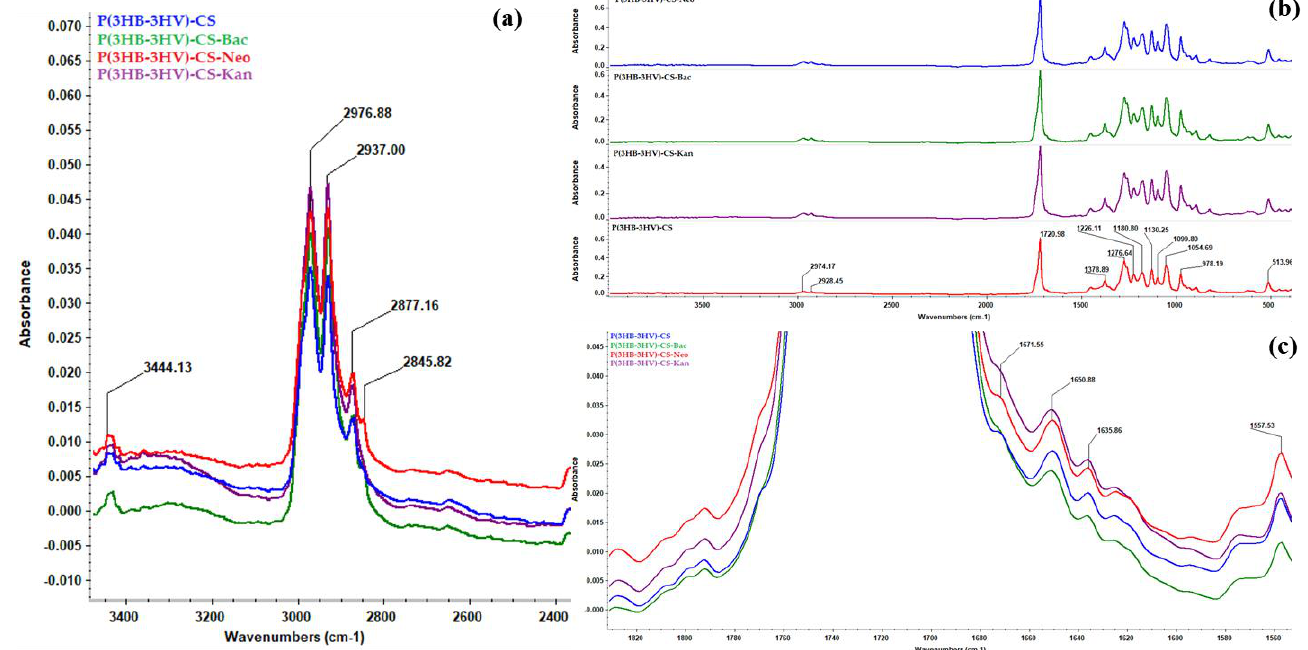
Figure 2. General IR spectra of P(3HB-3HV)-CS, P(3HB-3HV)-CS-Bac, P(3HB-3HV)-CS-Neo and P(3HB-3HV)-CS-Kan spheres ( b ), and zoomed in regions to evidence C-H ( a ) and amide ( c ) vibrations.